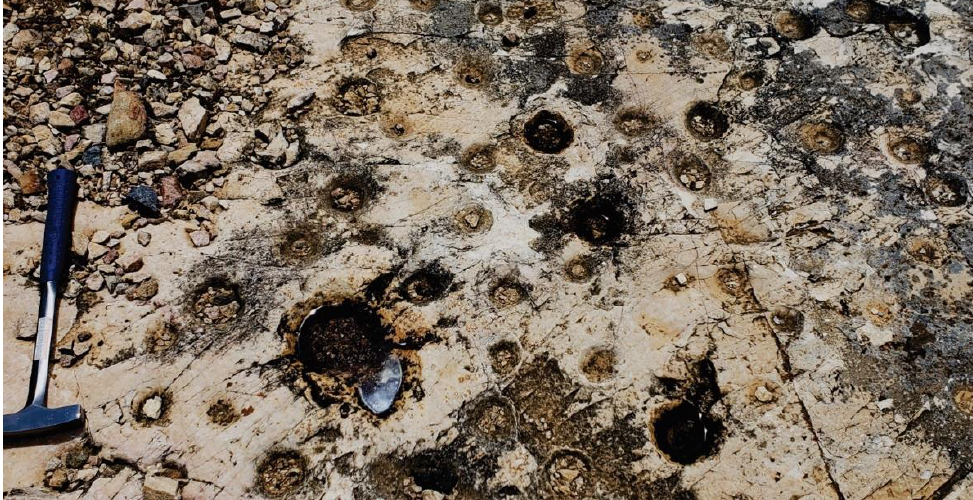
Figure 3. Ore crushing pits in marble platform above entrance of Kestel mine.